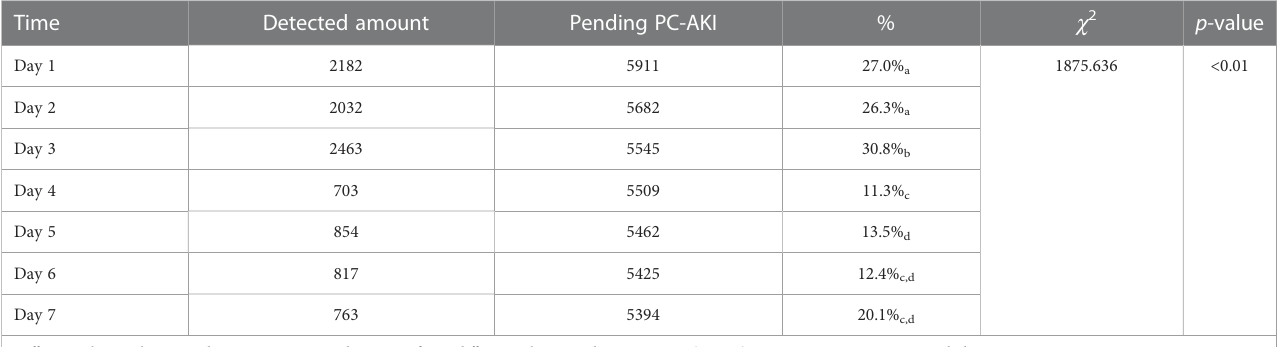
TABLE 2 Comparison of new incidence of PC-AKI detected daily after using contrast medium. Time Detected amount